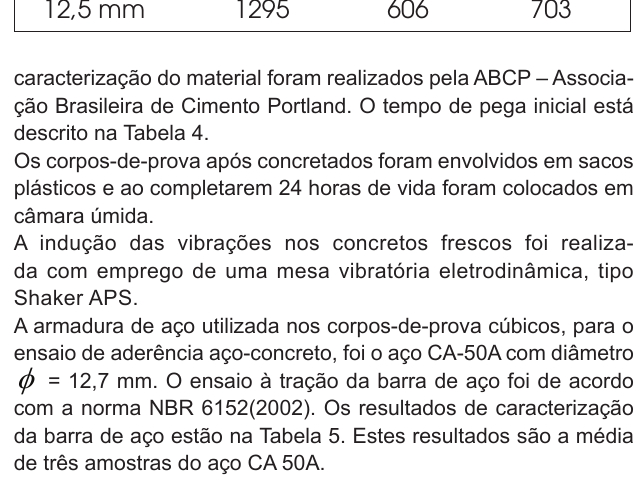
Figure 1 – Arranjo do ensaio dinâmico: (a) Mesa vibratória tipo Shaker APS fixa em base de concreto com corpo-de-prova prismático Tipo-II; (b) Arranjo de fixação de corpo-de-prova cilíndrico